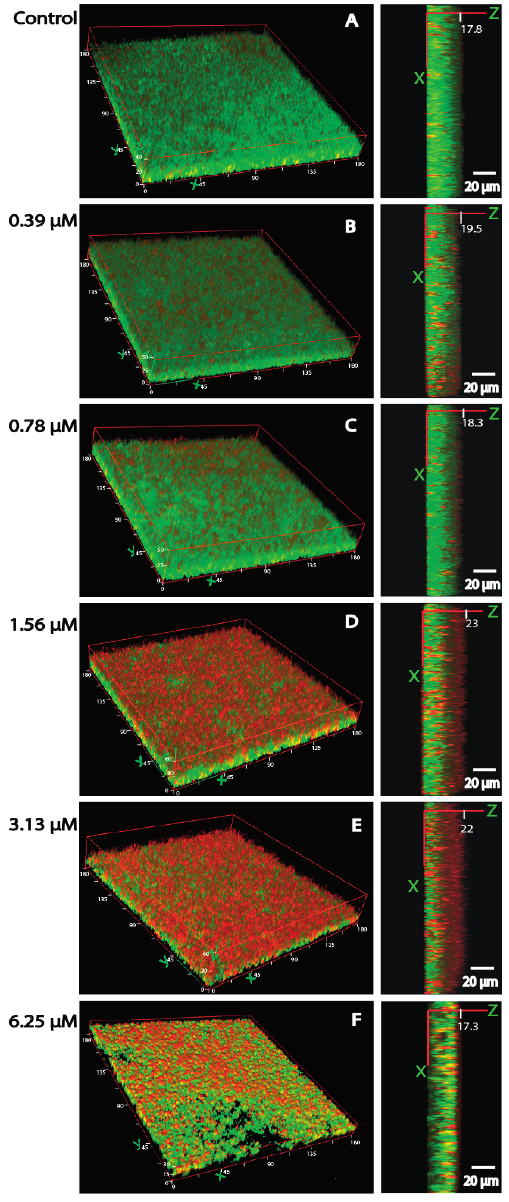
Figure 5. The thickness (right panel) and 3D (left panel) pictures of S. epidermidis (ATCC35984) measured by CLSM. Non-exposed (control) ( A ) or exposed to different concentrations (0.39–6.25 µM) ( B – F ) of cadmium. The thicknesses of biofilms from control to 6.25 µM treatment group were 17.8, 19.5, 18.3, 23, 22, and 17.3